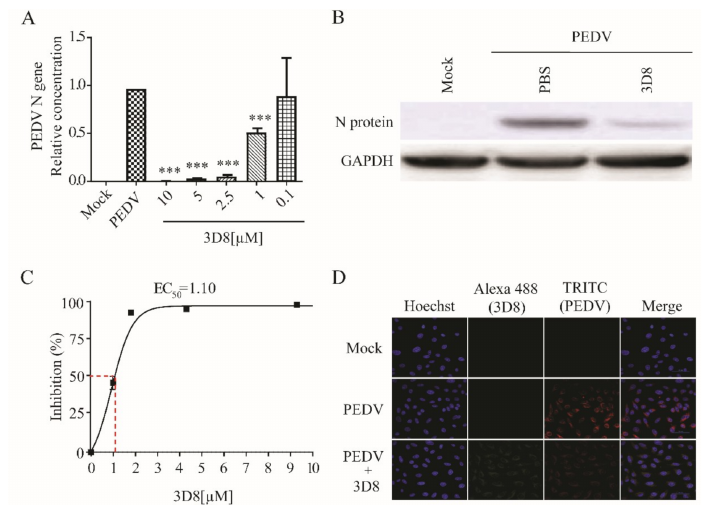
Figure 5. In vitro antiviral effect of different concentrations of 3D8 against porcine epidemic diarrhea virus (PEDV). ( A ) Dose-dependent inhibition of PEDV by 3D8. Vero E6 cells were infected with PEDV at 2 hpi and treated with a range of 3D8 concentrations for 48 hrs. The cells were harvested, and the viral RNA load was determined using qPCR. ( B ) The N protein of PEDV was identified by Western blot. ( C ) Percent inhibition of PEDV replication was shown by 3D8 in Vero E6 cells. Replication was measured via quantification of the viral RNA level. ( D ) At 48 hpi, the cells were washed with PBS and fixed with methanol. Then, they were permeabilized with buffer and blocked with BSA. The cells were incubated with primary antibodies overnight. After incubation, TRITC-conjugated anti-mouse and Alexa 488-conjugated anti-rabbit antibodies were added. Hoechst was used to stain the nucleus. Data presented here are representative of at least three independent experiments performed in triplicate. *** p < 0.001; one-way ANOVA test; ns: